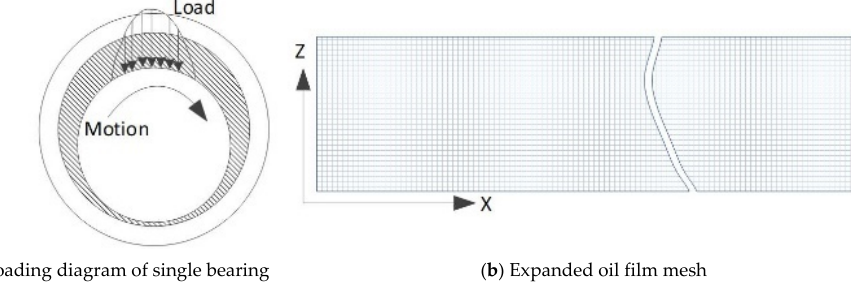
Figure 4. Bearing load of a single bearing friction pair and oil film.